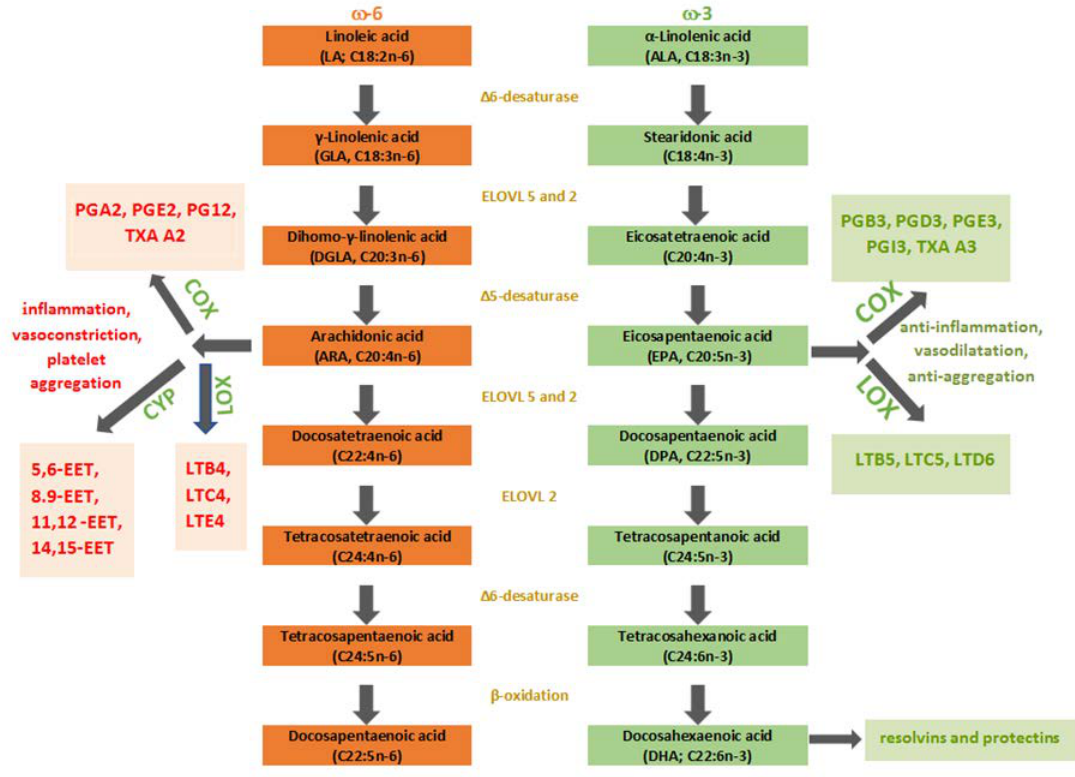
Figure 1. Schematic presentation of the PUFAs pathway. ω -3, omega-3 fatty acids; ω -6, omega-6 fatty acids; COX, cyclooxygenase; CYP, cytochrome P450; EET, epoxyeicosatrienoic acid; ELOVL, elongase; LOX, lipoxygenase; LT, leukotriene; PG, prostaglandin; TXA, thromboxane.